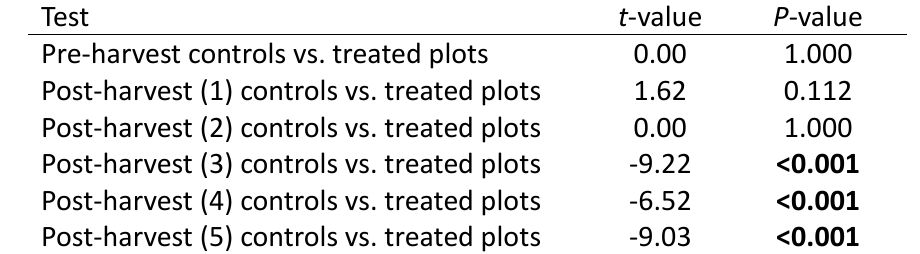
Table A1.5 . Year-specific treatment effects on density of Mourning Warbler, according to multiple comparison analyses (DF = 40).